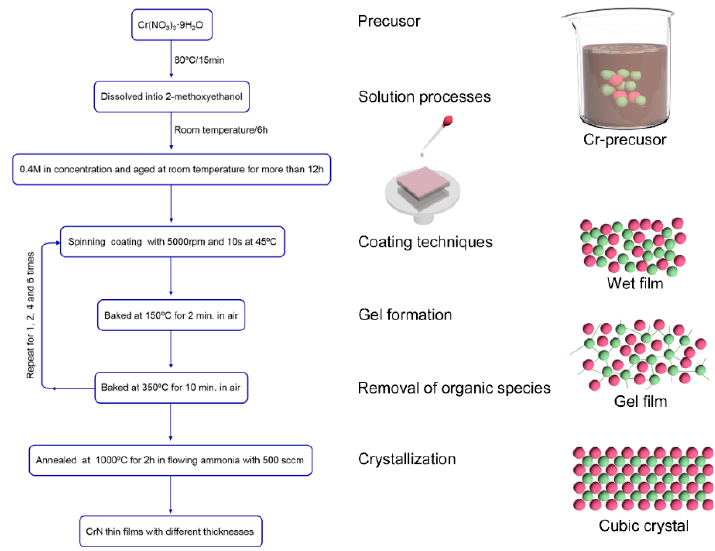
Figure 1. Flow chart of preparation of CrN thin films by the CSD method.